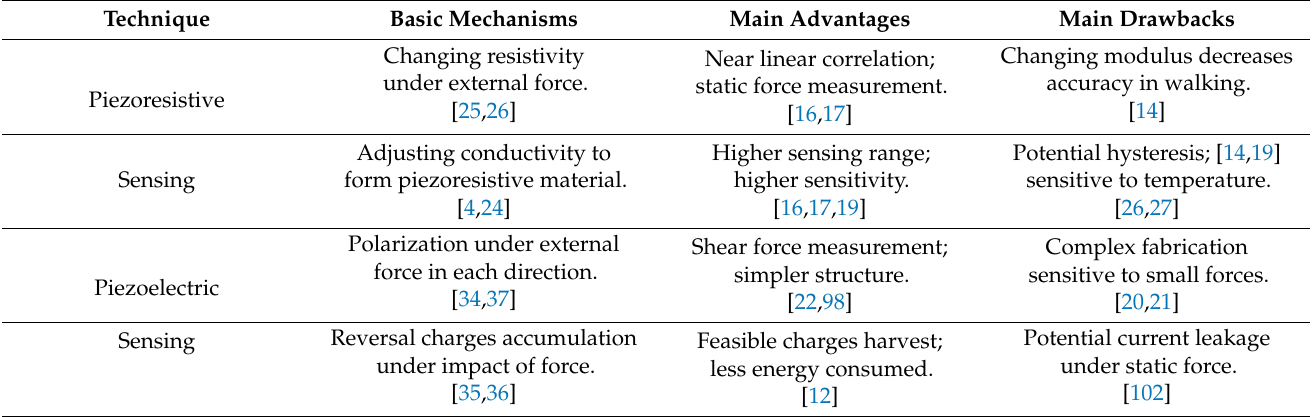
Figure 7. Diseases suitable for monitoring and why via two techniques: piezoresistive sensors are suitable for diseases requiring higher accuracy and larger detecting area, examples of which are stroke, PD, and KOA [103,104]. Piezoelectric sensors are suitable for diseases requiring longer working time and shear force detection, examples of which are diabetic foot, elderly falling, and flat foot [105,106]. Table 3. Comparison of two techniques’ mechanisms: advantages and drawbacks. Each technique has two separate and typical mechanisms. Advantages and drawbacks were derived from mecha- nisms.